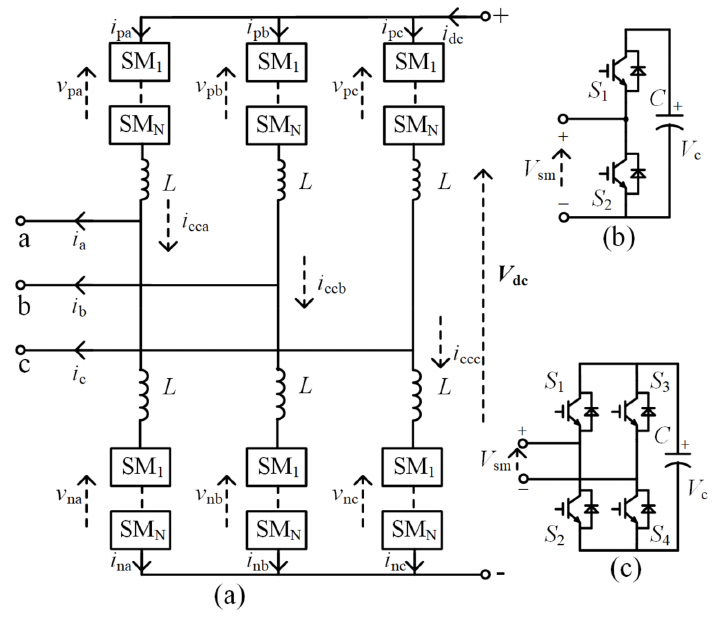
Figure 1. The modular multi-level converter structure diagram. ( a ) Modular multilevel converter (MMC) topology; ( b ) Half-bridge sub-module; and ( c ) Full-bridge